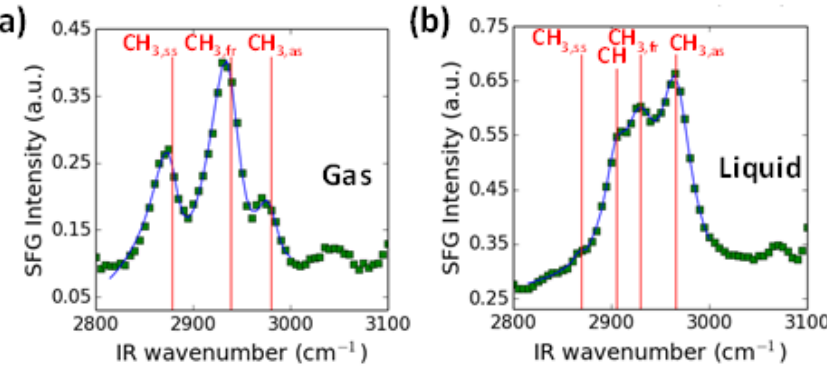
Figure 8. SFG spectra obtained on the surface of 4 nm Pt nanoparticles for 2-PrOH oxidation under ( a ) gas phase and ( b ) liquid phase reaction conditions. (SFG data for 2-PrOH oxidation were reported in [22]. Reprinted with permission from [22]. Copyright 2014 American Chemical Society.).